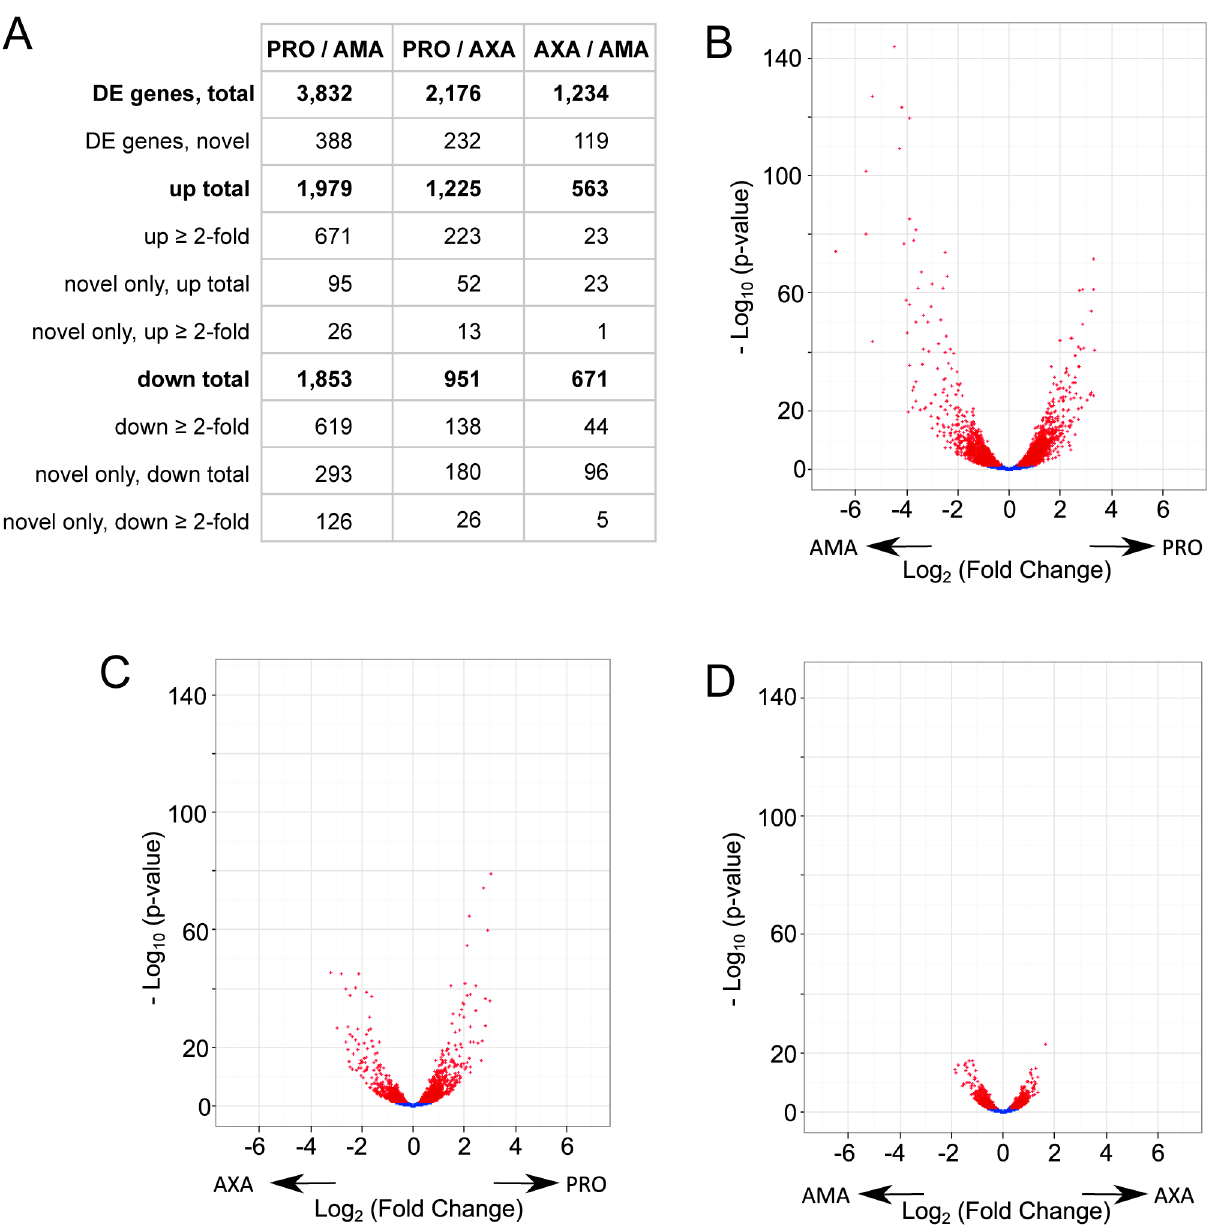
Fig 7. Differential gene expression between AMA, AXA and PRO. (A) Table summarising the number of differentially expressed (DE) genes in each pair- wise comparison; “ novel ” refers to the 936 novel transcripts defined in this study. (B-D) Volcano plots for the comparisons between PRO and AMA (B), PRO and AXA (C), AXA and AMA (D). Each dots represents one transcript; red denotes differential expression (padj (cid:3) 0.05). Arrows indicate the cell type showing higher